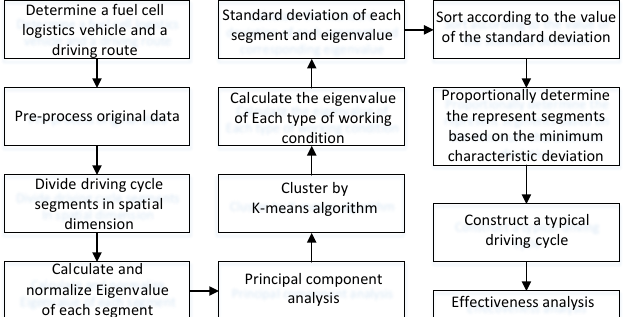
Figure 1. Construction method of driving cycle for fuel cell logistics vehicle.